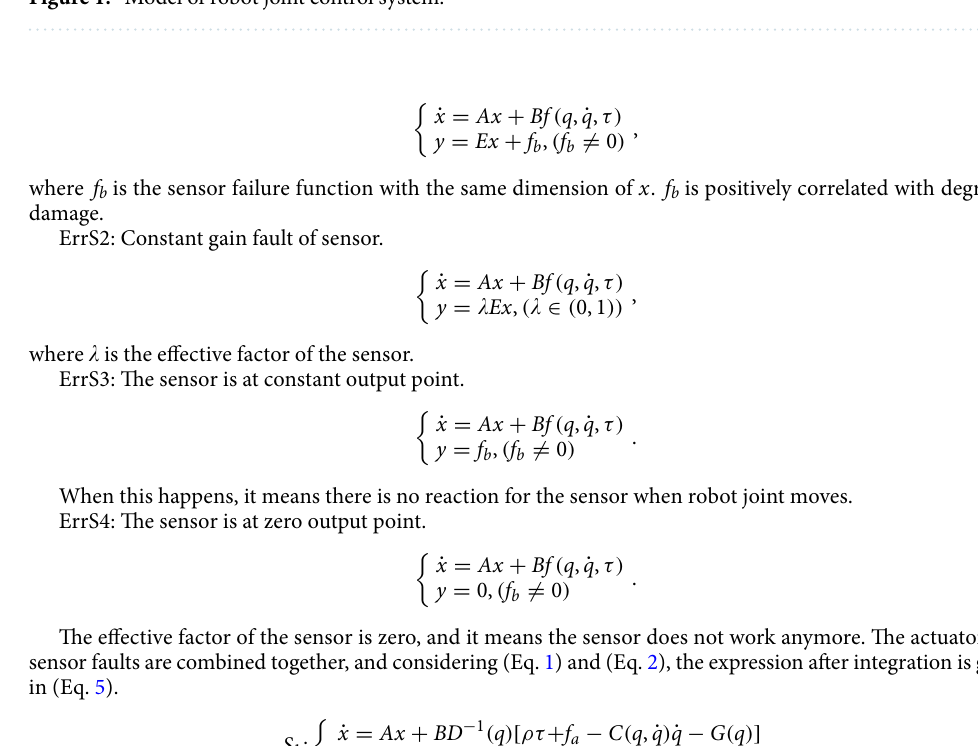
Figure 1. Model of robot joint control